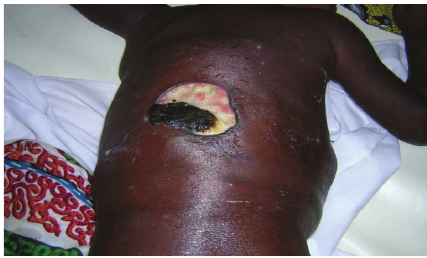
Figure 2: BU of the